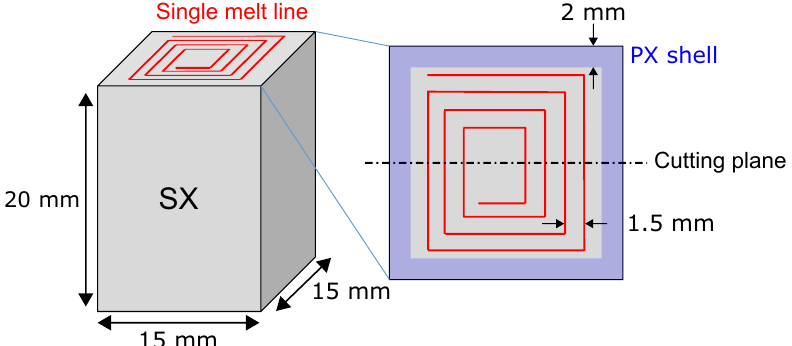
Figure 2. Single crystalline sample with spiral single melt line on top in addition to sample dimensions, polycrystalline shell, distance between adjacent melt lines, and cutting plane for metallographic preparation.